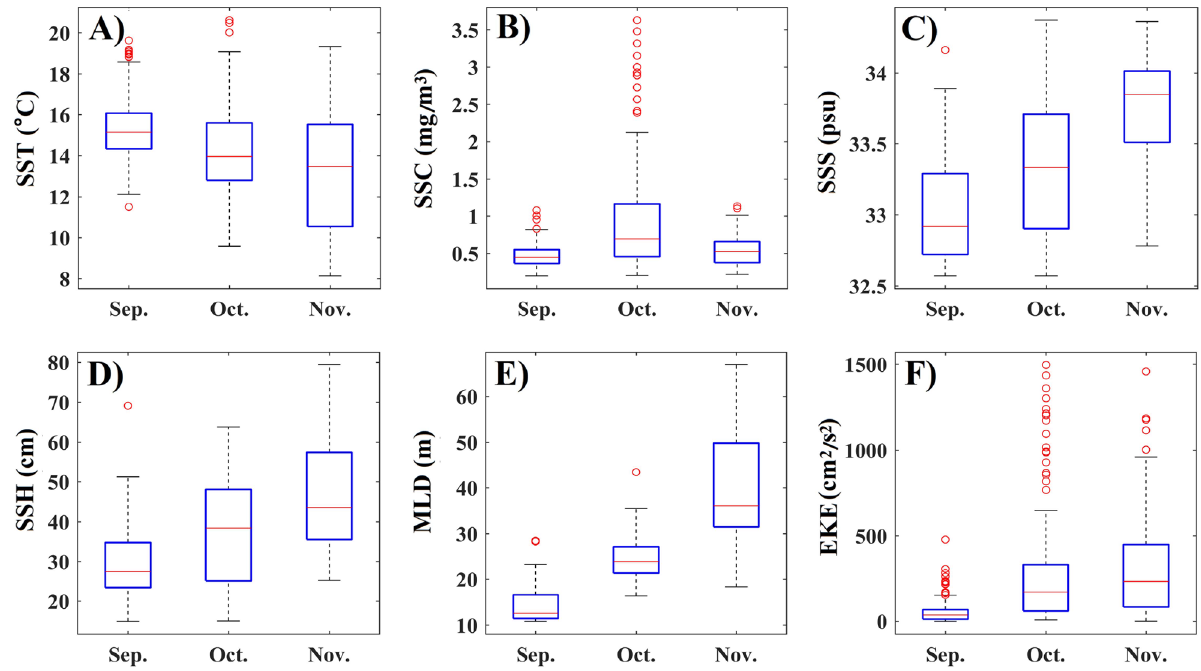
Figure 3. Box plot of environmental variables affecting Pacific saury in the northwestern Pacific in September– November between 2014 and 2017: ( A ) SST; ( B ) SSC; ( C ) SSS; ( D ) SSH; ( E ) MLD; and ( F ) EKE.